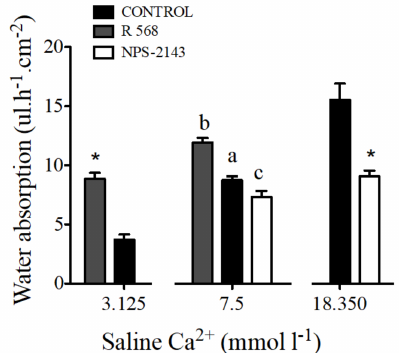
Figure 6. Water absorption ( µ L · h − 1 · cm − 2 ) in response to R 568 (100 µ M) or NPS-2143 (100 µ M) in sea bream anterior intestine sacs with different working concentrations of apical calcium. Results are shown as mean ± SEM ( n = 5–17). Asterisks represent significant differences in relation to the matching controls ( p < 0.05, Student’s t -test); and different letters show significantly differences ( p < 0.05, one-way ANOVA, followed by the Bonferroni’s Multiple Comparison